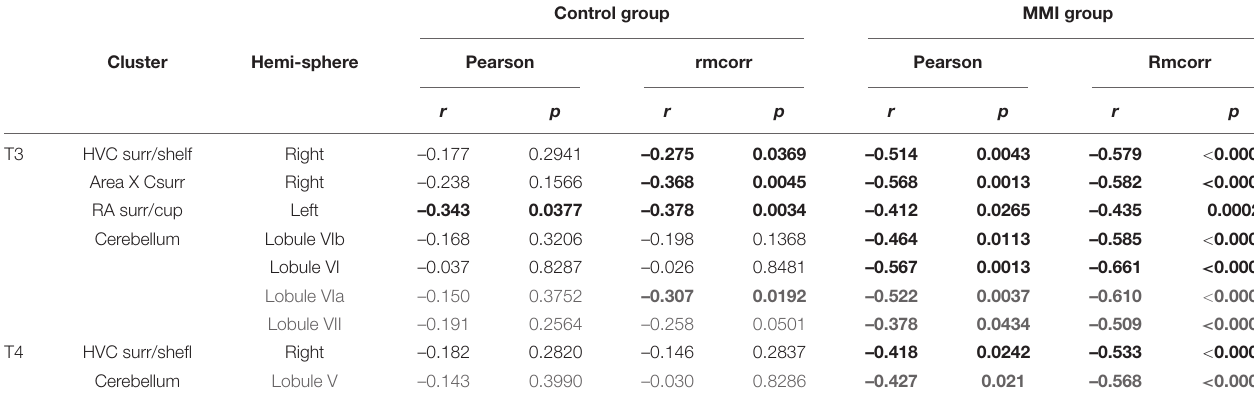
TABLE 3 | Summary of the overall and repeated measures correlation of thyroid hormones T3 and T4 for control and MMI-treated group separately. Control group